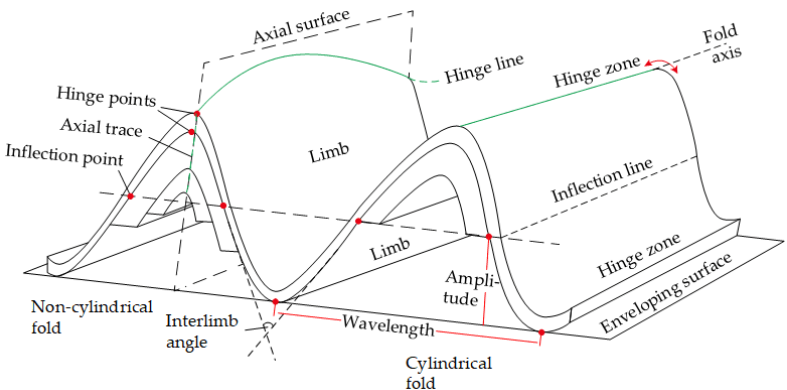
Figure 1. Diagram of fold structure characteristics. Table 1. Main fold types and their characteristic parameters